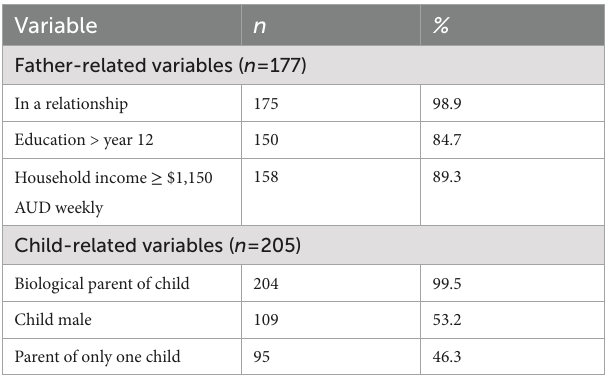
TABLE 1 Descriptive characteristics of the analytic